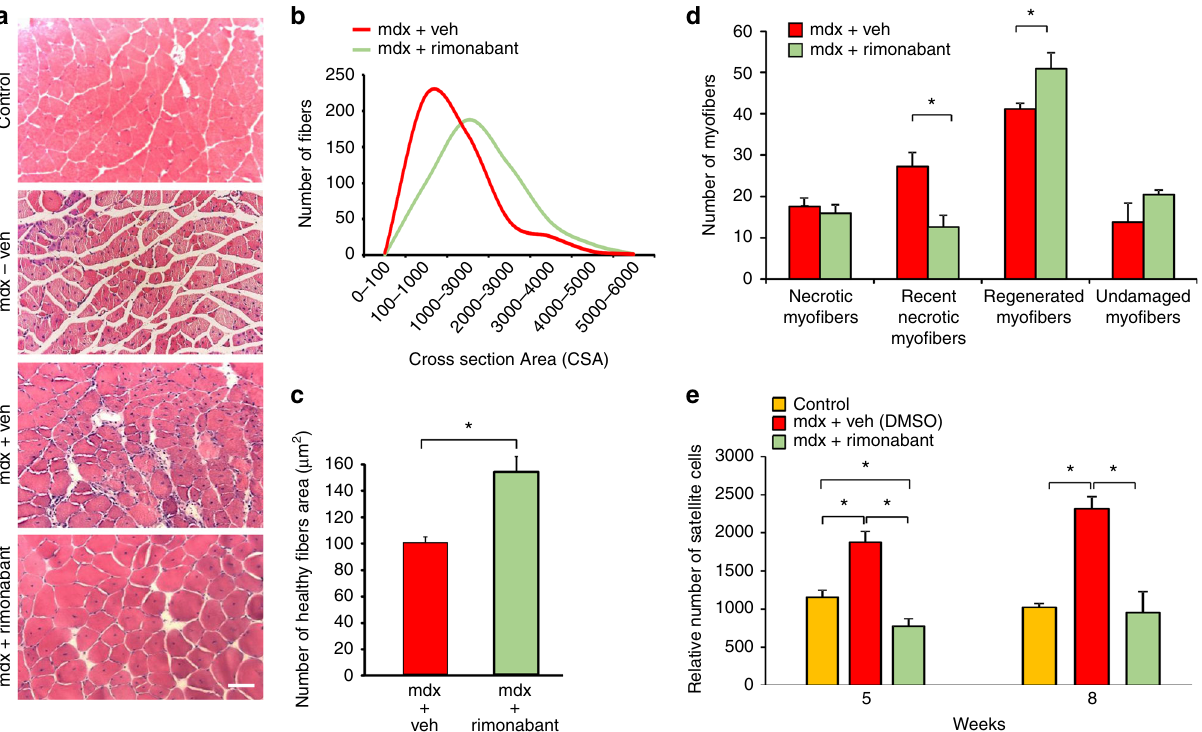
Fig. 7 Effects of rimonabant on muscle degeneration. a Representative photomicrographs of H&E-stained transverse sections of gastrocnemius muscles isolated from wild-type (control, n = 6); mdx mice (without vehicle, n = 6); mdx mice treated with vehicle (DMSO, n = 6), or rimonabant ( n = 6) 0.5mgKg − 1 IP from week 5 to week 7 of age. Scale bars = 100 μ m. b Total number of myo fi bers within each cross-sectional area (CSA, µ m 2 ). c number of healthy myo fi bers within each cross-sectional area (CSA, µ m 2 ). d Bar graph indicates the number of necrotic, partially regenerated (recently necrotic), fully regenerated and undamaged myo fi bers in control (DMSO) and rimonabant-treated mdx mice. Mice were treated from week 5 to week 7 of age. Each bar is the mean±SEM. * P ≤ 0.05 vs. vehicle group, determined by Student ’ s t test. e Bar graph showing the relative number of satellite cells found in